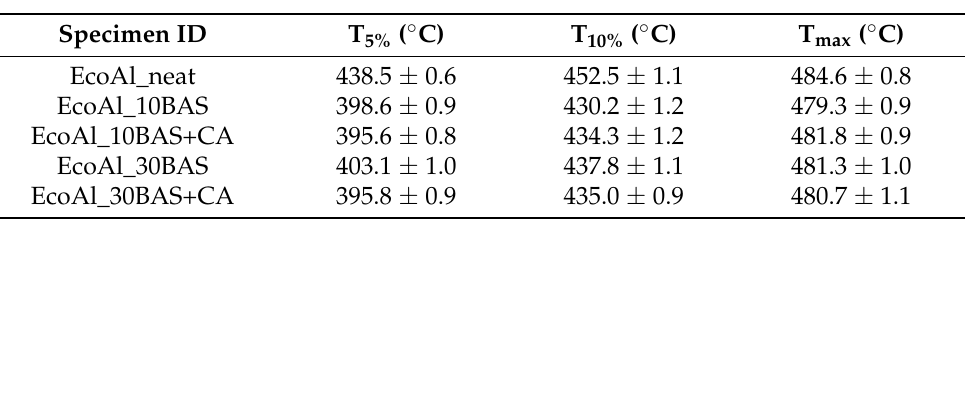
Table 2. T 5% , T 10% , and T max for EcoAllene-based formulations obtained from TGA